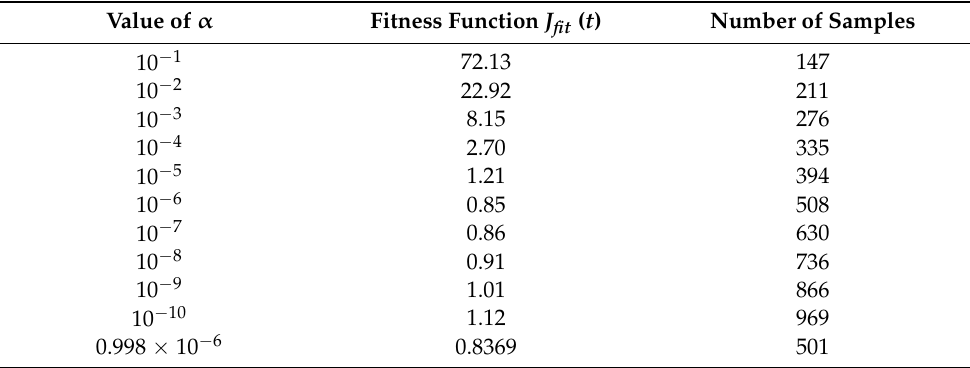
Table 2. Fitness Function and Number of Samples for Inverted Pendulum System.